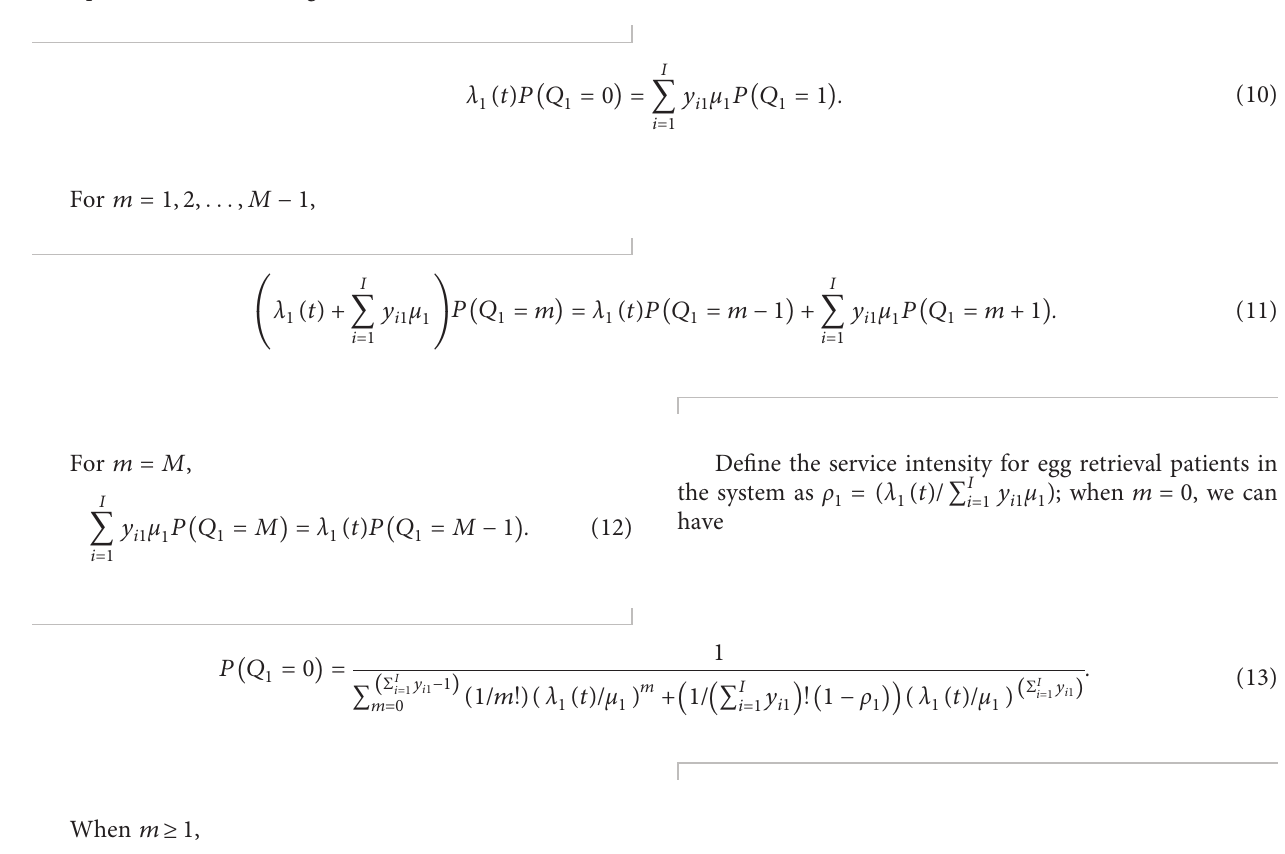
The infertile patients in the cloud healthcare system come from different community hospitals; in that sense, the scale of this problem is a large one. In order to effectively solve the proposed problem, the state transition diagram in Figure 3 is simplified. Given the number of patients in type 2, the state transition diagram of patients in type 1 in the t th time period is shown in Figure